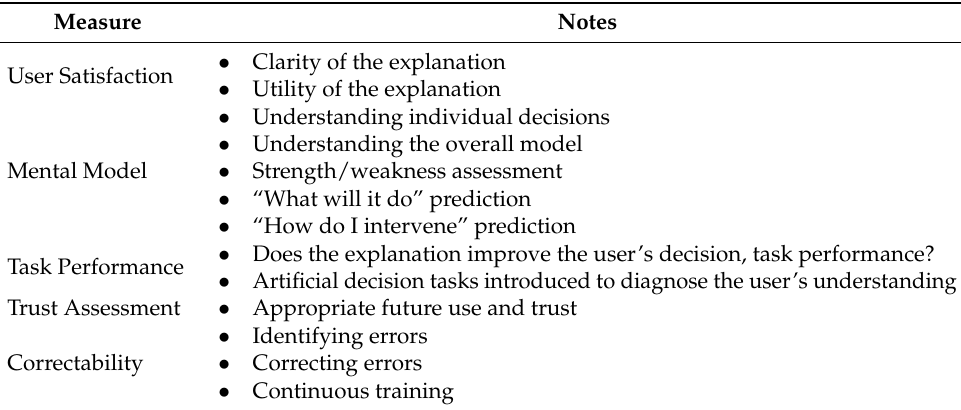
Table 5. Metrics of explanation quality [26].